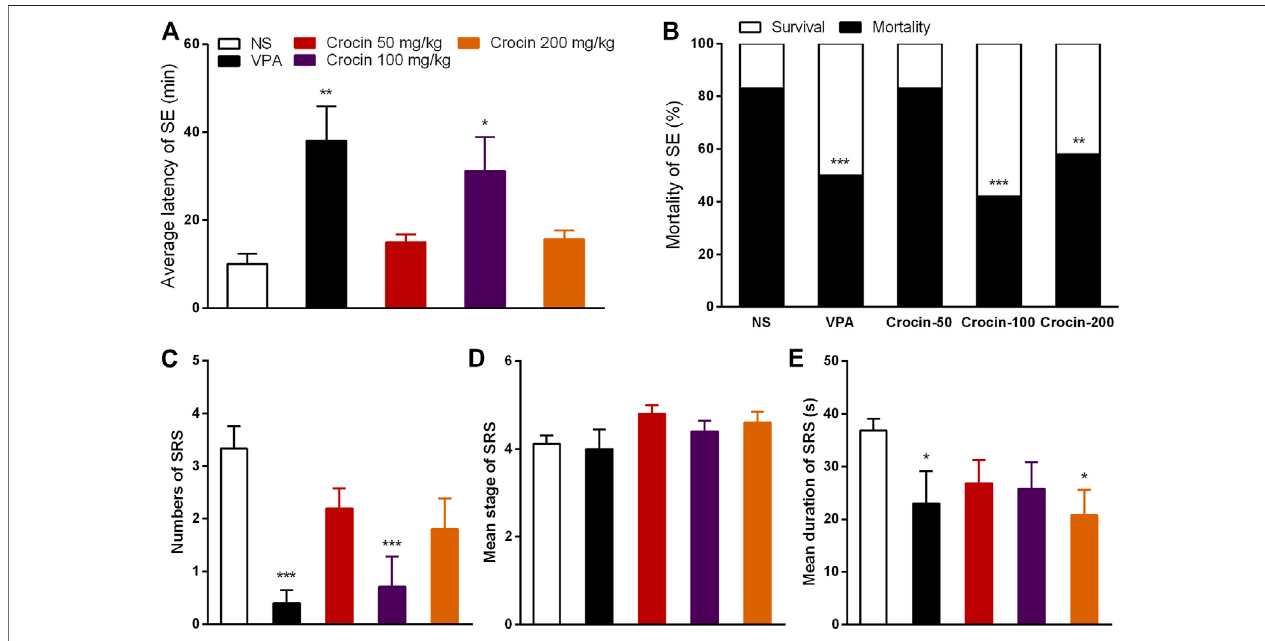
FIGURE 4 | Effects of crocin on pilocarpine-induced SE and SRS. (A) average latency of SE ( n = 12 for each group, x (cid:1) ±S.E.M.); (B) mortality rate of SE ( n = 12 for each group); (C) number of SRS ( n = 7 for each group, x (cid:1) ±S.E.M.); (D) mean seizure stage of SRS ( n = 7 for each group, x (cid:1) ±S.E.M.); (E) mean duration of SRS ( n = 7 for each group, x (cid:1) ±S.E.M.). SE, status epilepticus; SRS, spontaneous recurrent seizures; NS, normal saline; VPA, sodium valproate. Values are from four independent experiments. * p < 0.05, ** p < 0.01, *** p < 0.001, compared with NS group. One-way ANOVA for repeated measures was used followed by Tukey ’ s t-test for (A,C,D) and the χ 2 test was used for (B)